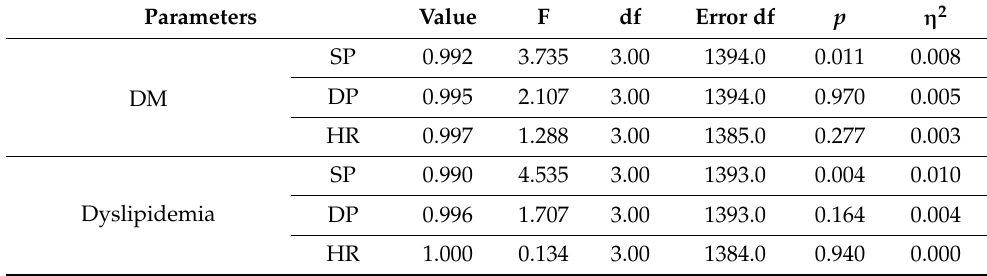
Figure 2. Box plot for differences between measurements of diastolic pressure (DP) in experimental and control groups during the follow-up of patients. Statistical difference was confirmed by Wilcoxon test and marked with asterisk (* = p < 0.05). Table 5. Multivariate analysis of variance (MANOVA) in study population depending on presence of diabetes mellitus, dyslipidemia, smoking, hereditary factors, and time. An eta-squared ( η 2 ) value reflects the strength or magnitude related to a main or interaction effect (0.01 = small, 0.06 = medium, 0.13 =